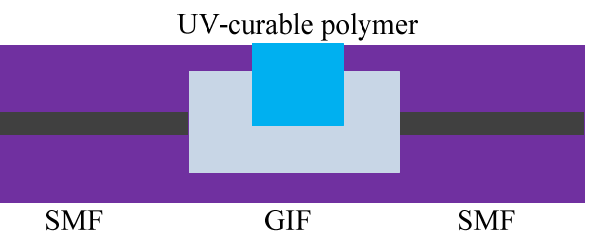
Figure 21. The MZI sensor based on GIF and UV-polymer [92].